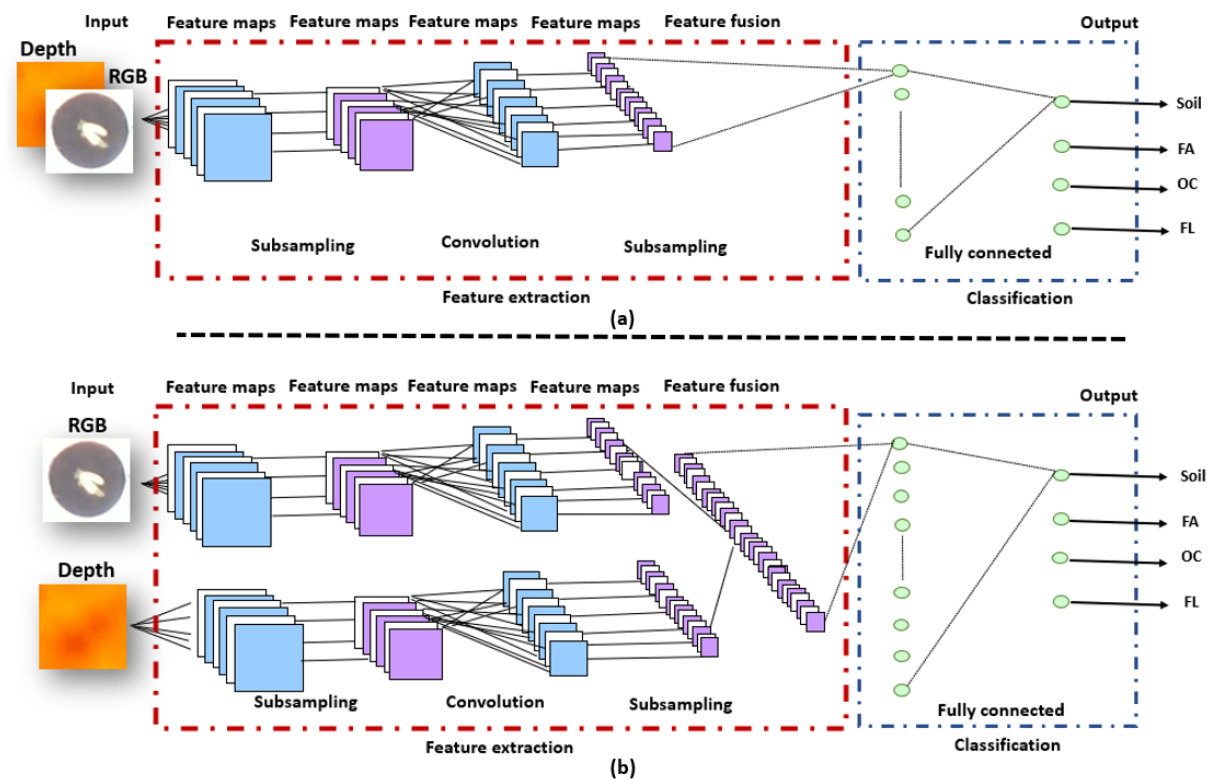
Figure 3. ( a ) CNN architecture of image fusion for RGB-Depth, ( b ) CNN architecture of features fusion for